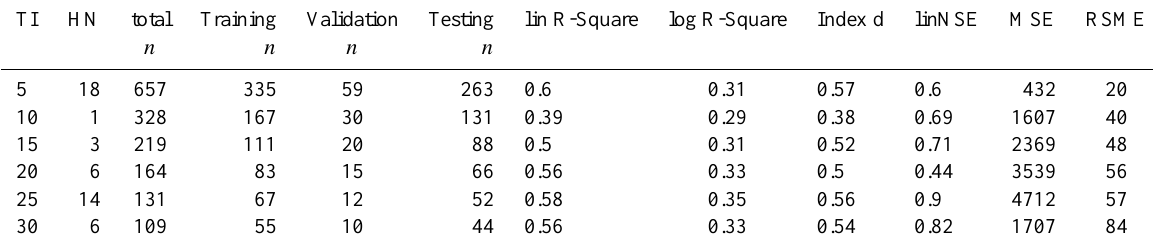
Table 6. Artificial neural net setup and performance.